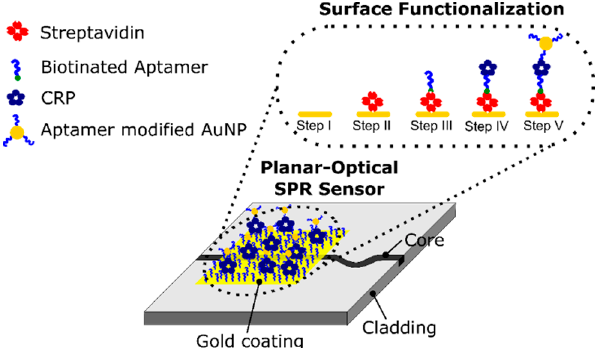
Figure 1. Schematic of the developed polymer based multi-mode (MM) planar-optical waveguide surface plasmon resonance (SPR) sensor. By using a gold-nanoparticle (AuNP)-enhanced aptamer-based sandwich assay, the shift of the SPR wavelength due to the binding of the target molecule (in this case C-reactive protein (CRP)) is increased.